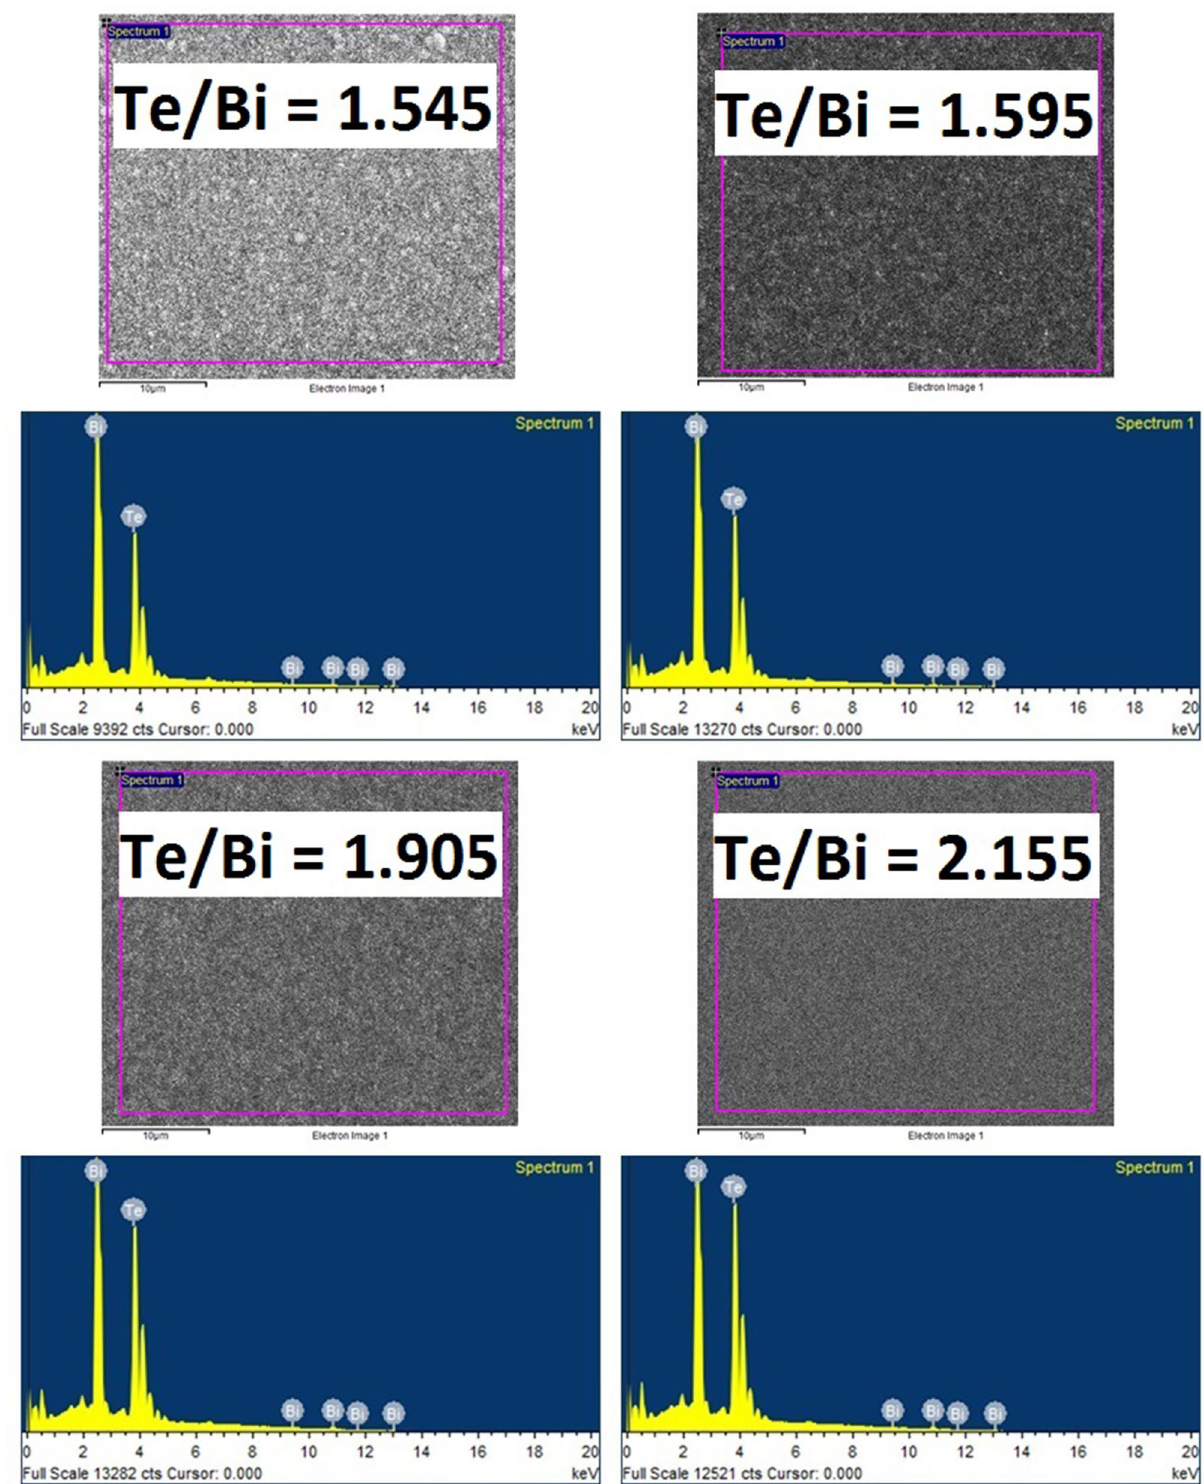
Figure 2. EDS mapping images and spectrums of the selected Bi–Te thin films after thermal